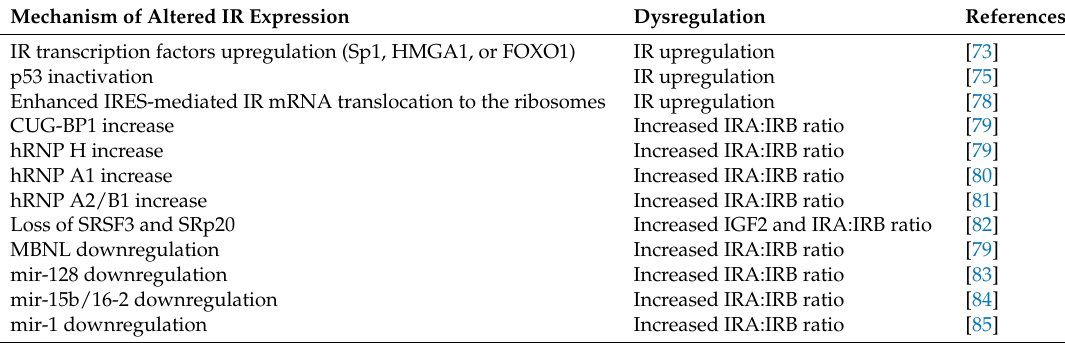
Table 2. Molecular mechanisms associated with IR dysregulated